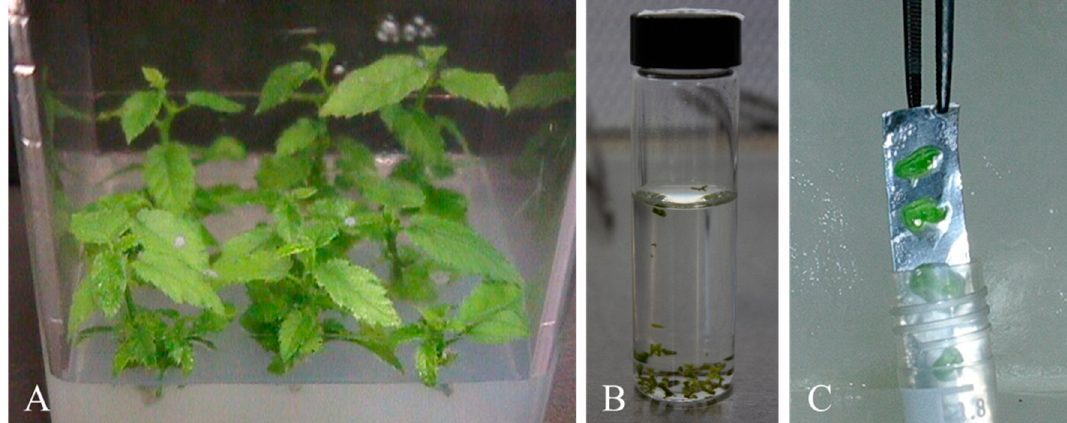
Figure 1. ( A ) shoots multiplication of hazelnut, cultivated variety Tonda Gentile Romana, ( B ) axillary buds in loading solution, ( C ) explants in droplets of vitrification solution plunged in liquid nitrogen on a strip of aluminium foil.